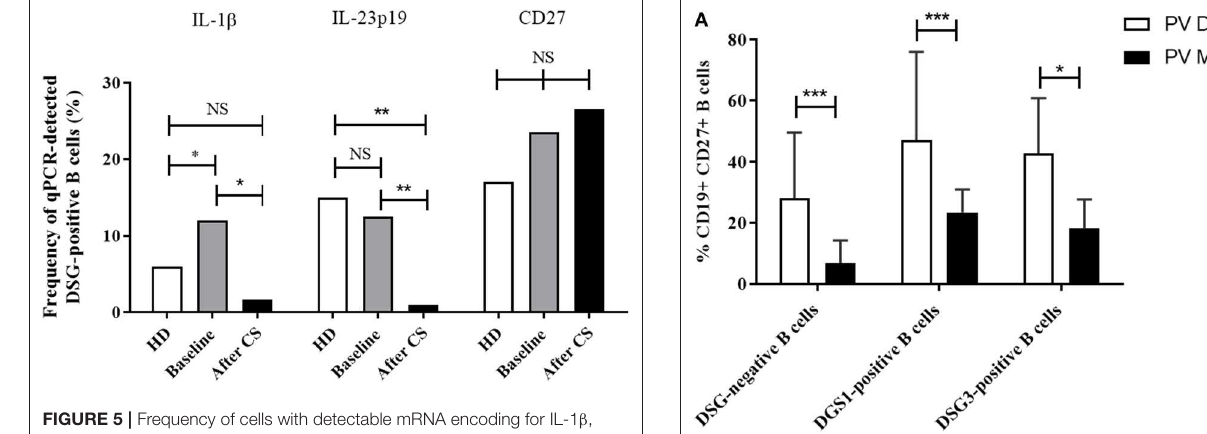
FIGURE 5 | Frequency of cells with detectable mRNA encoding for IL-1 β , IL-23p19, and CD27 in one-cell sorted desmoglein-positive from healthy donors (white columns, n = 107 cells) compared to pemphigus patients before treatment before (gray columns, n = 191 cells) and after CS treatment (black columns, n = 120 cells). Frequencies were compared using the Fisher’s exact test.